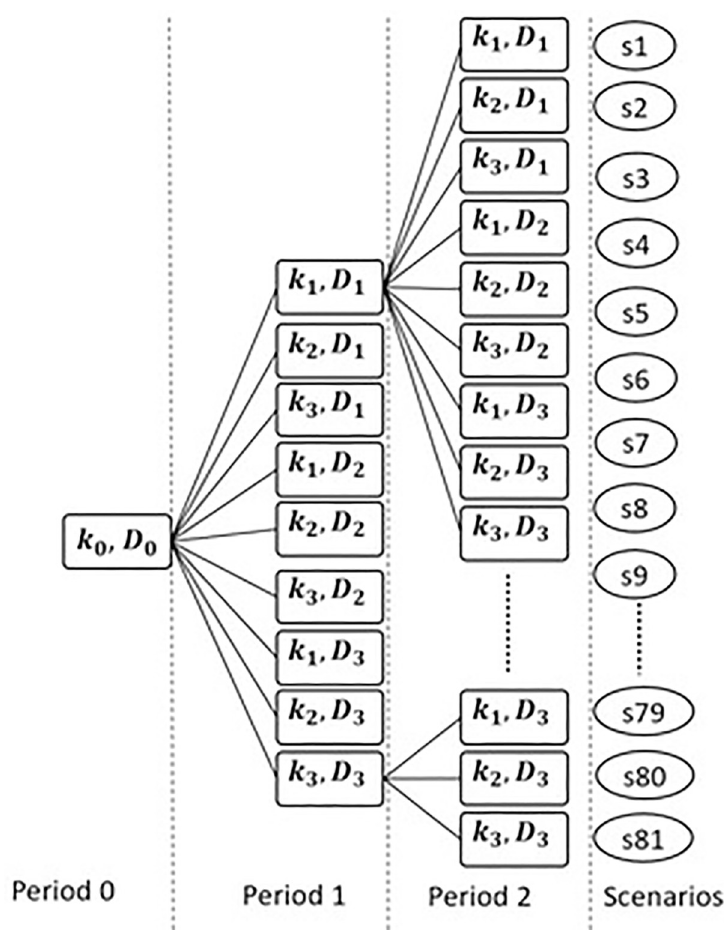
Fig 1. Scenario tree for stochastic Model-I and Model-II. Own